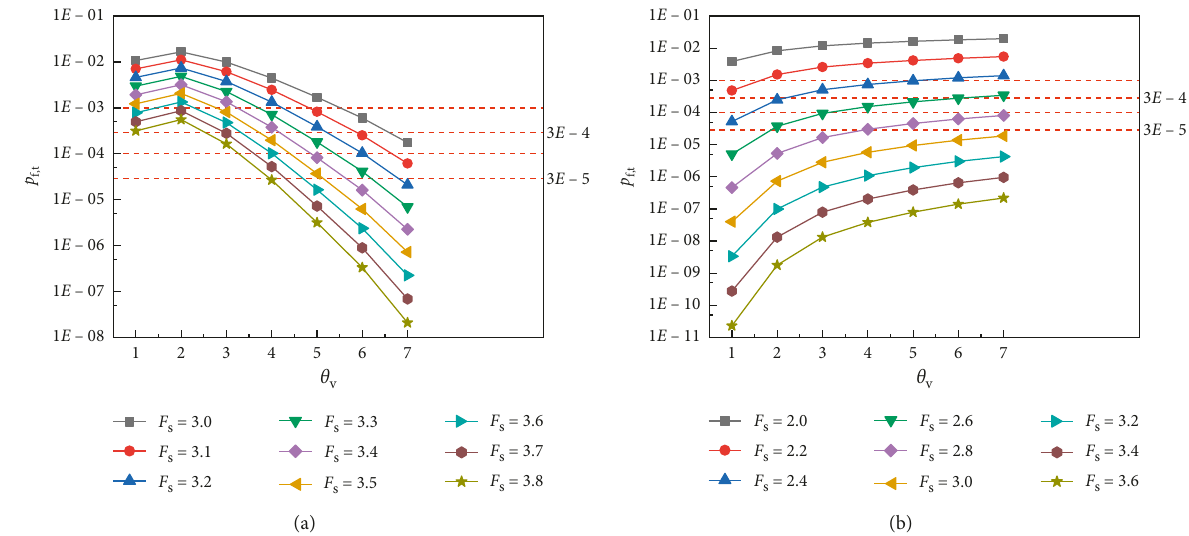
Figure 14: Probability of tension failure of tunnel liner under different random fields as a function of the vertical correlation length and factor of safety: (a) CRF and (b)